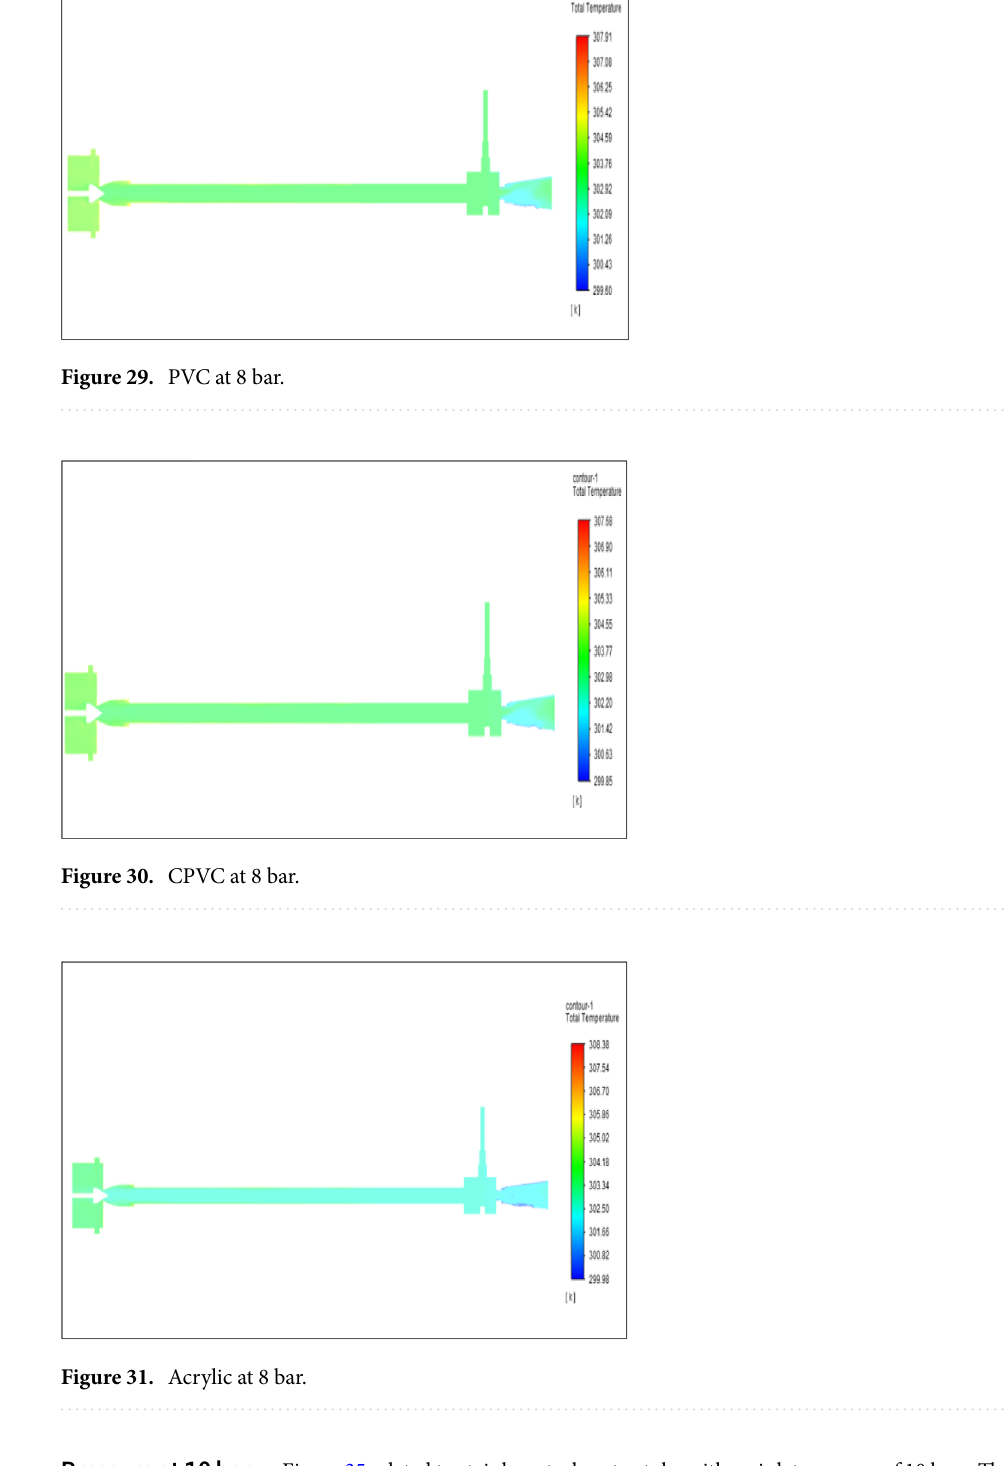
Figure 35 related to stainless steel vortex tube with an inlet pressure of 10 bars. The inlet temperature of the VT is 303 K. The hot air temperature was obtained at the hot end as 309.59 K. Similarly, the cold end side obtained a value of 298.95 K. The maximum temperature difference was noticed as 10.64 K. Figure 36 related to a brass vortex tube with an inlet pressure of 10 bars. The inlet temperature of the VT is 303 K. The hot air temperature was obtained at the hot end as 309.51 K. Similarly at the cold end side obtained value was 298.82 K. The maximum temperature difference was noticed as 10.69 K.